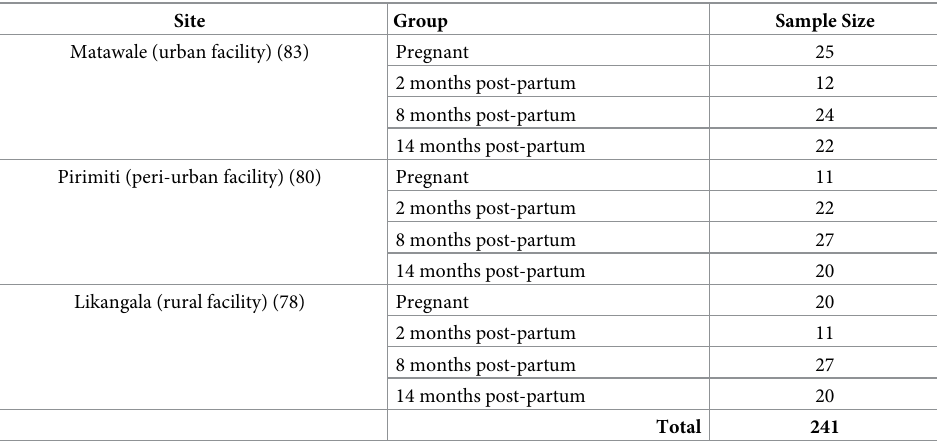
Table 1. Sample size and